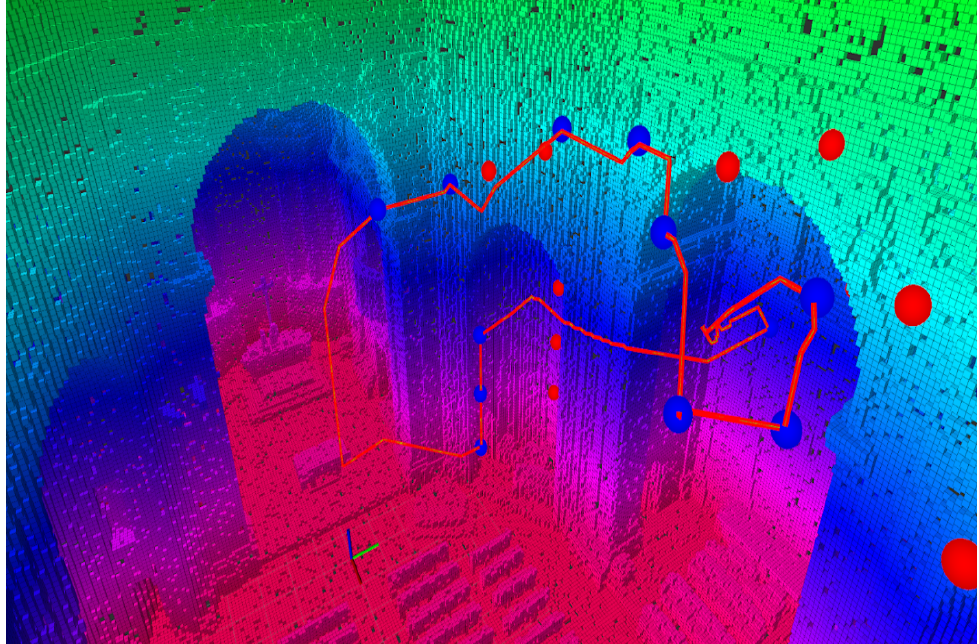
Figure 2. A scanning plan generated with the use of the model of the environment created from the scans obtained with the 3D terrestrial laser